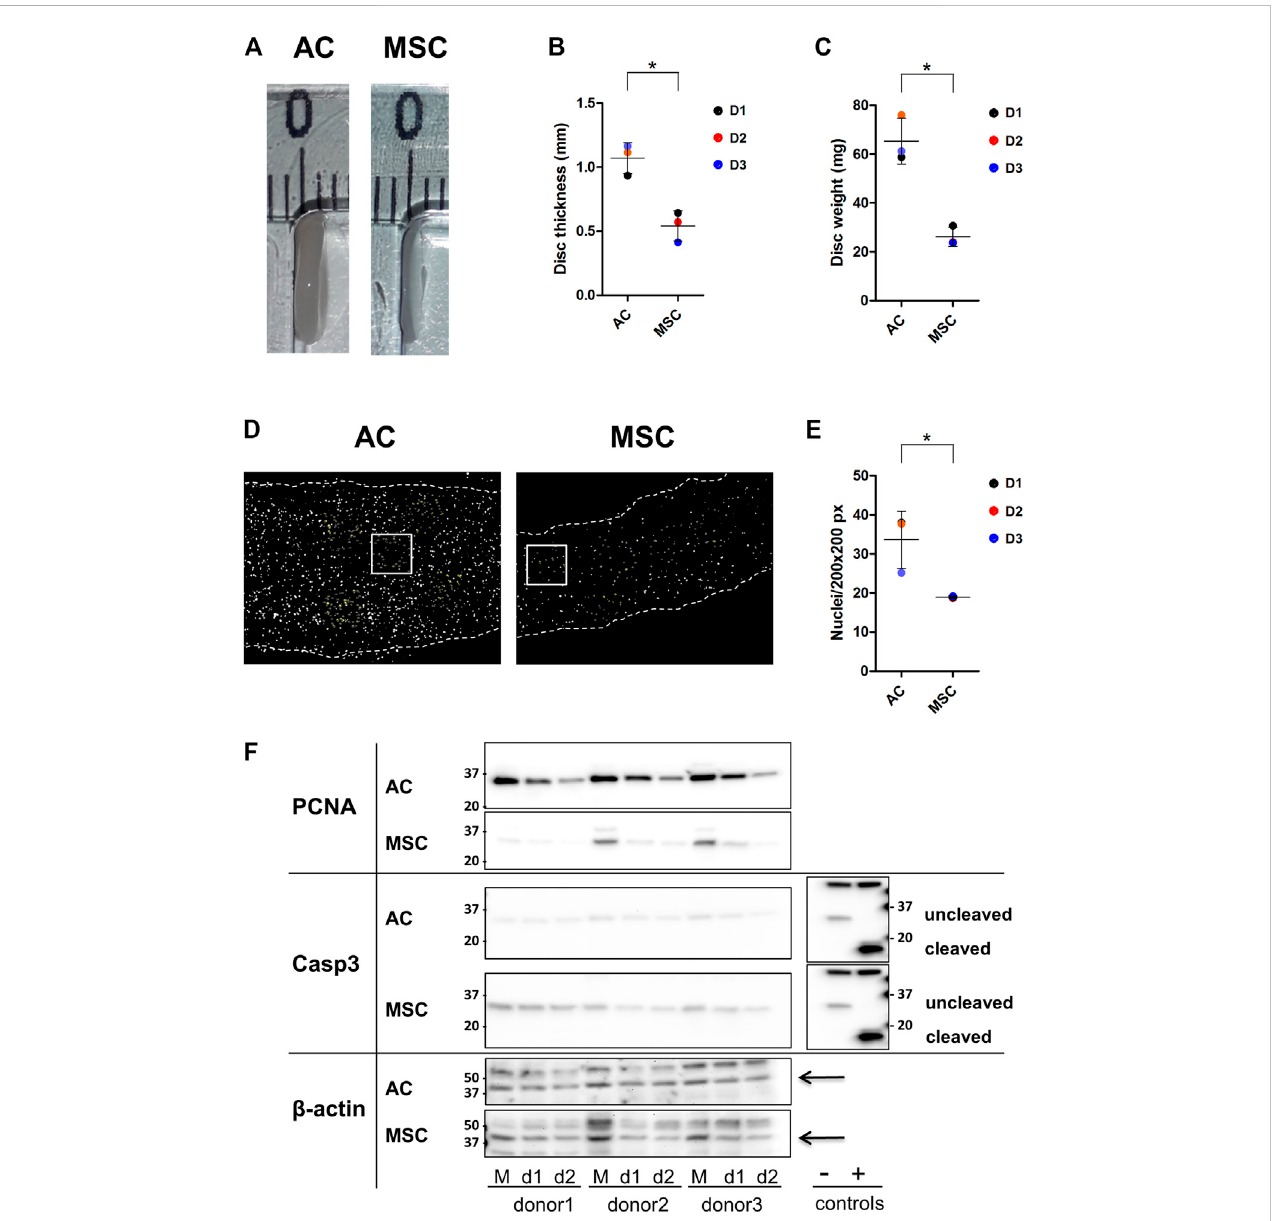
FIGURE 2 Properties of ACand MSC discs (A) Photograph of representativecartilageconstructsmade byACs (left)and MSCs (right). (B) Thickness (disc height) and (C) wetweightof4-weekcartilagediscsfromACsandMSCs.DatapresentedasdotplotdiagramwithmeanandSD;D1-D3(donor1 – 3). (D) Nucleicountof4- week cartilage discs from ACs and MSCs. Nuclei were counted from representative size-de fi ned areas (200 px × 200 px; examples marked with a white box). Nuclei are shown in white. Dashed lines indicate the edges of the cartilage disc section. (E) Dot plot diagram of nuclei count with mean and SD; D1-D3 (donor 1 – 3). (F) Western blotanalysis. Protein levels of PCNA, Caspase-3 (Casp-3) and cleavedCasp-3wereanalysedin monolayer samples (M) and in day-1- (d1) and day-2-discs (d2) of ACs and MSCs. Casp-3 control extracts (Jurkat cell extracts untreated ( − ) or treated (+) with cytochrome c in vitro ) showing procaspase-3( − )and cleaved Casp-3(+). Beta actinwas usedas loading control andis indicatedbyarrows.Sampleswerederivedfrom thesameexperiment, AC and MSC samples wereloaded on two separategels, and gels/blotswereprocessed in parallel. Images showing AC and MSC membranes exposed side by side were inverted in Fiji, contrast and brightness were adjusted for beta actin and PCNA. For better comparison, the blot from Casp-3 control extracts has been mirrored and is presented twice. Finally, images were cropped horizontally to show the region of interest. Full-length blots are presented in Supplementary Figure S1 and different exposures of PCNA and Casp-3 are shown in Supplementary Figures S2, S3. Protein quanti fi cation data is shown in Supplementary Figure S4. Student ’ s t -test was used for statistics, and p ≤ 0.05 was considered signi fi cant. N = 3 for each experimental group and degrees of freedom (DF) = 4. Wet weight data is based on two discs per